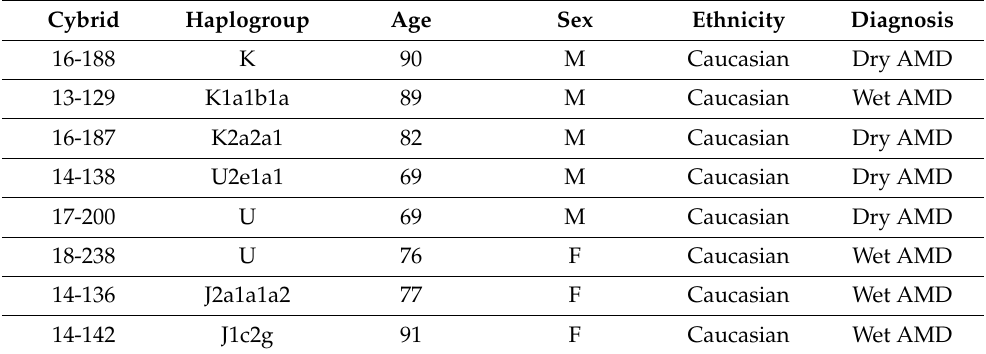
Table 1. Demographics of the K, U and J